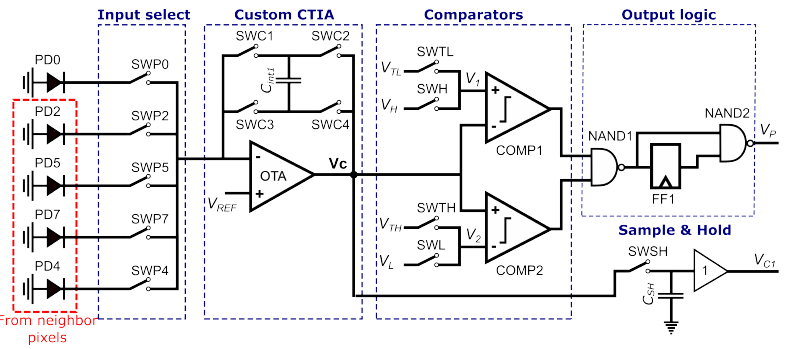
Figure 3. Defective pixel detection